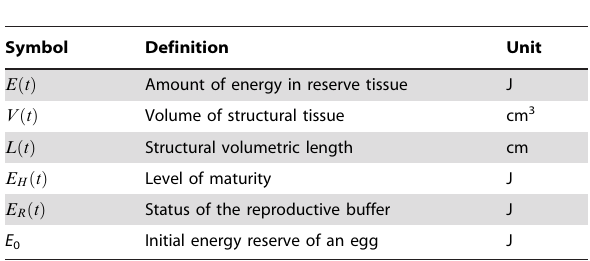
Table 1. List of symbols I: state and auxiliary variables.